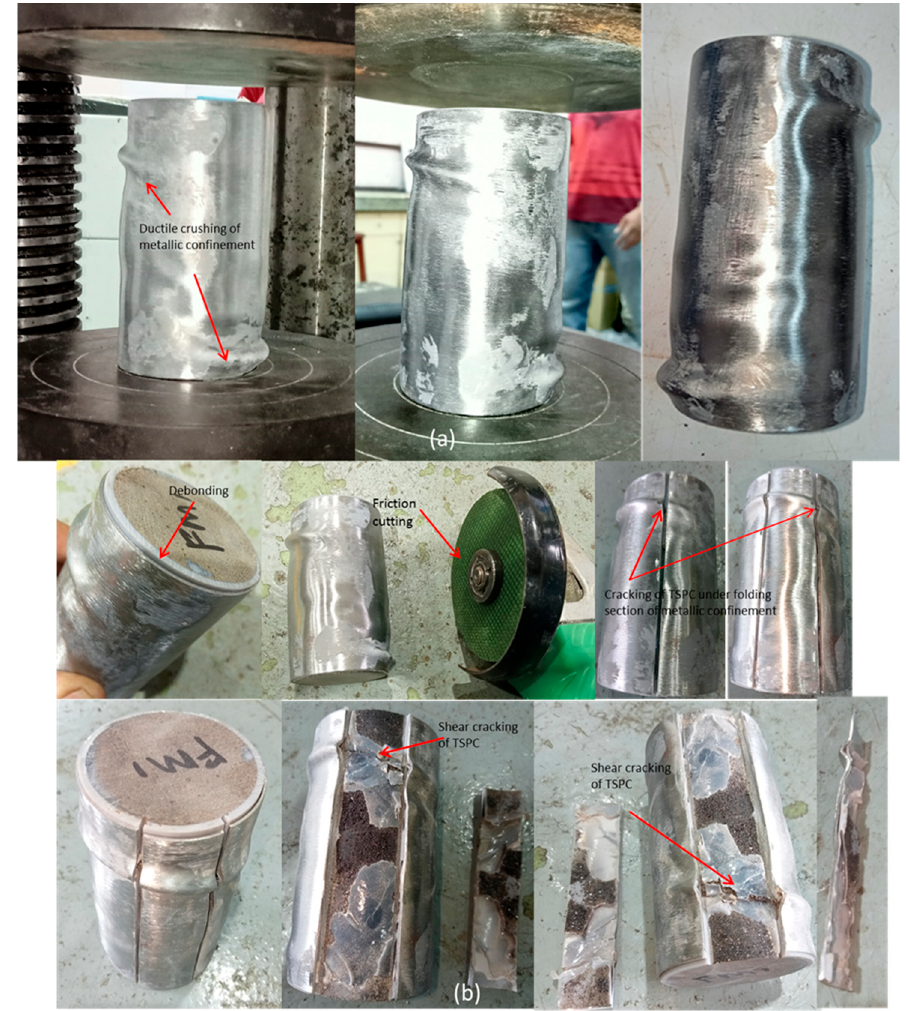
Figure 12. Failure modes of TSPC with fully metal tube confinement. ( a ) FM sample condition after mechanical testing. ( b ) The cut open of metal tube confinement for internal failure examination. Table 4. Summary of failure modes on all test samples.